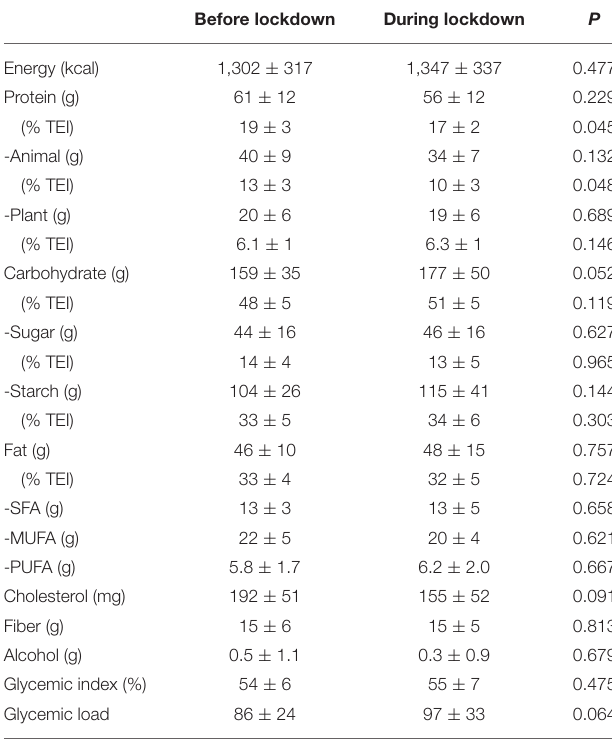
TABLE 1 | Daily energy intake and dietary composition obtained through 7-day food records completed before and during the lockdown in the type 1 diabetes (T1D) study participants ( n =